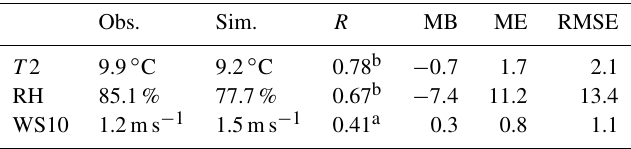
Table 3. Statistical metrics of comparisons between simulated (Sim.) and observed (Obs.) 2m air temperature ( T 2), surface relative humidity (RH), and 10m wind speed (WS10) with the correlation coefficient ( R ), mean bias (MB), mean error (ME), and root mean squared error (RMSE) during air pollution period between 2 and 7 January 2017. Obs. Sim. R MB